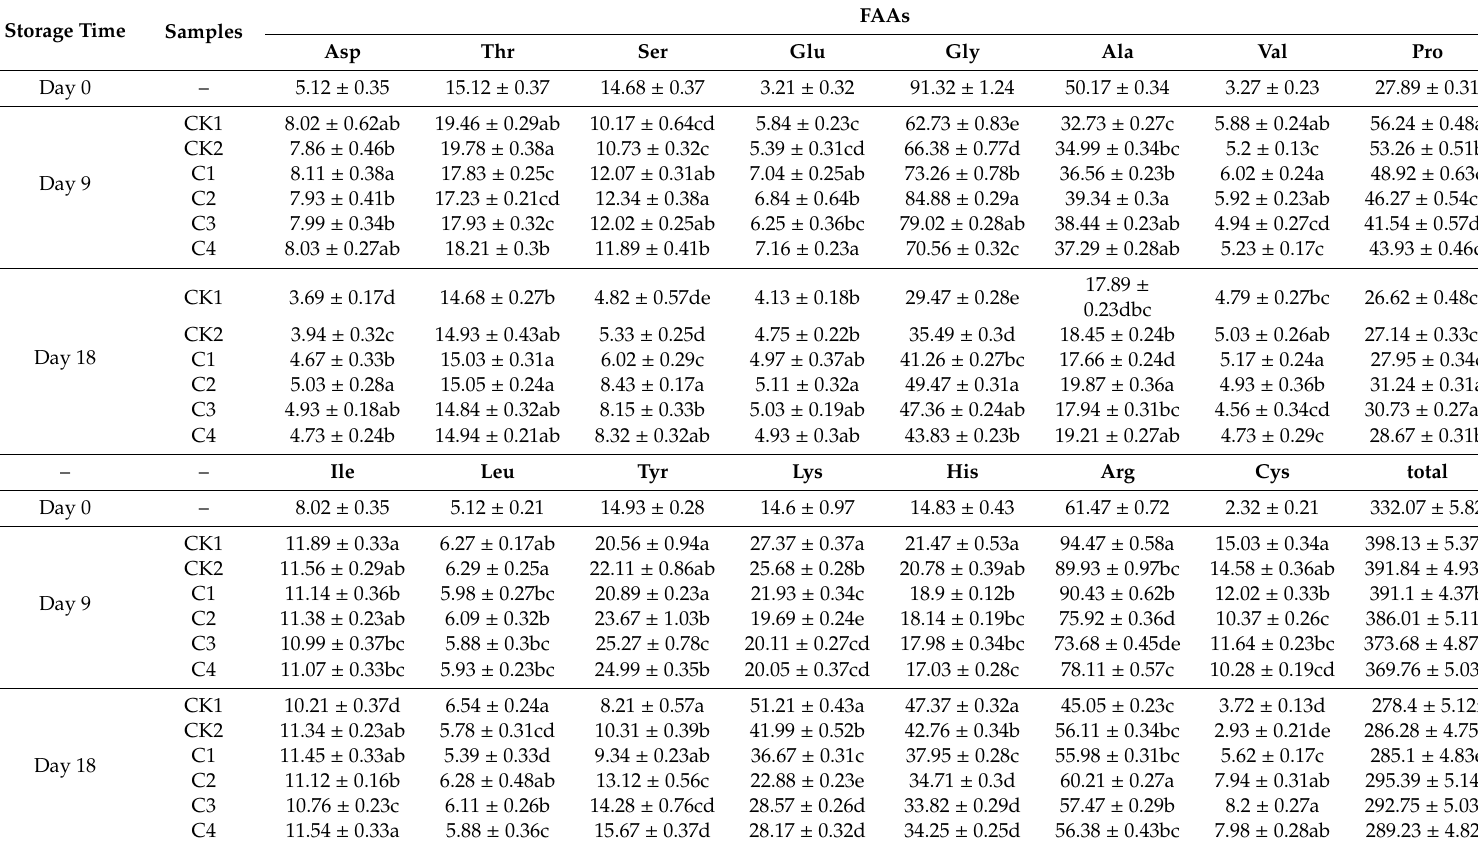
Table 2. Changes in free amino acids (FAAs) content (mg / 100 g) in di ff erent treated samples during refrigerated